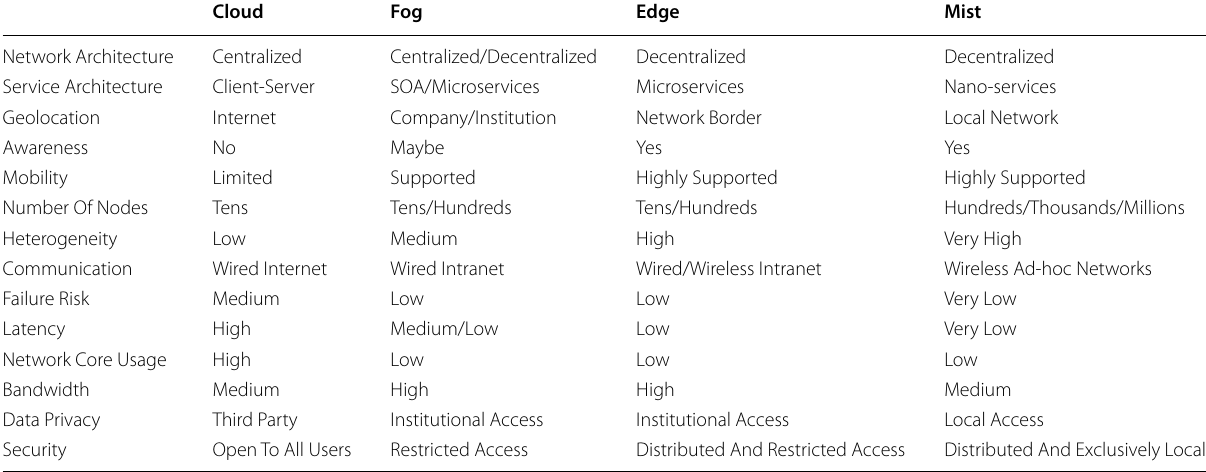
Table 2 Essential features of Cloud, Fog, Edge and Mist Computing